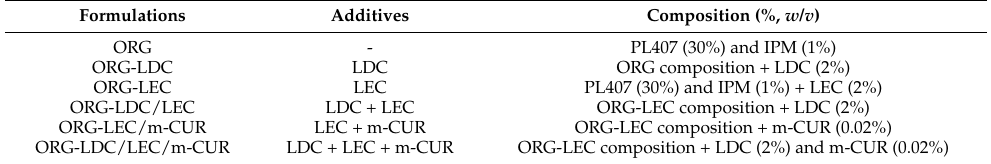
Table 1. Prepared organogels (ORG) formulations. All ORG are composed of an aqueous phase of PL407 30% w / v and an oil phase of isopropyl myristate (IPM). LDC: Lidocaine hydrochloride, LEC: soy lecithin, m-CUR: synthesized monoketone